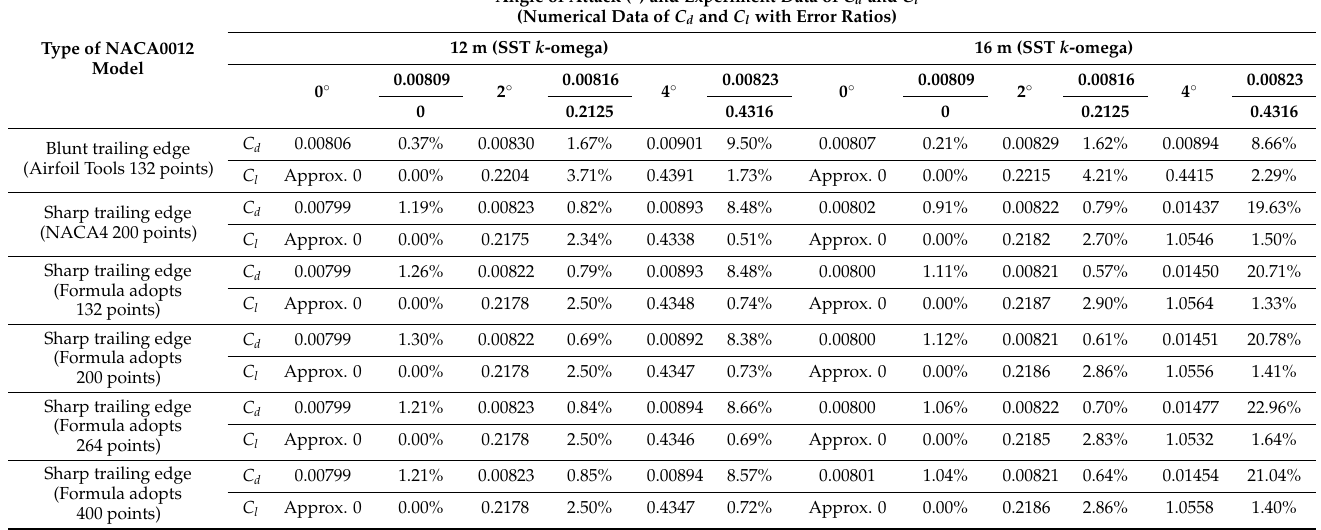
Table 5. Simulation results of C d and C l with error ratios adopting SST k-omega and far-field distances of 12 m and 16 m.